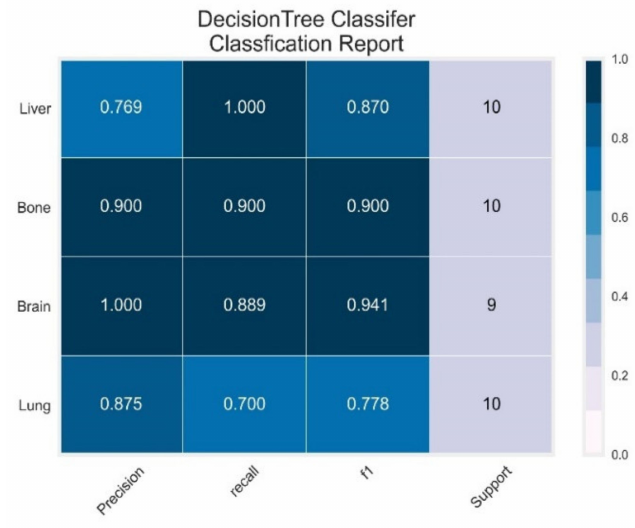
Figure 14. Classification Report (Decision Tree